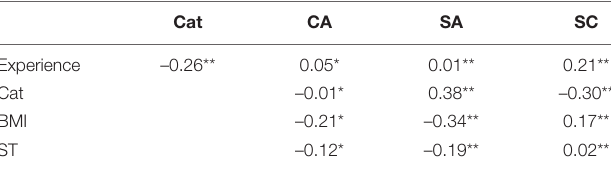
TABLE 3 | Relationship between psychological variables and category, experience, BMI and specific